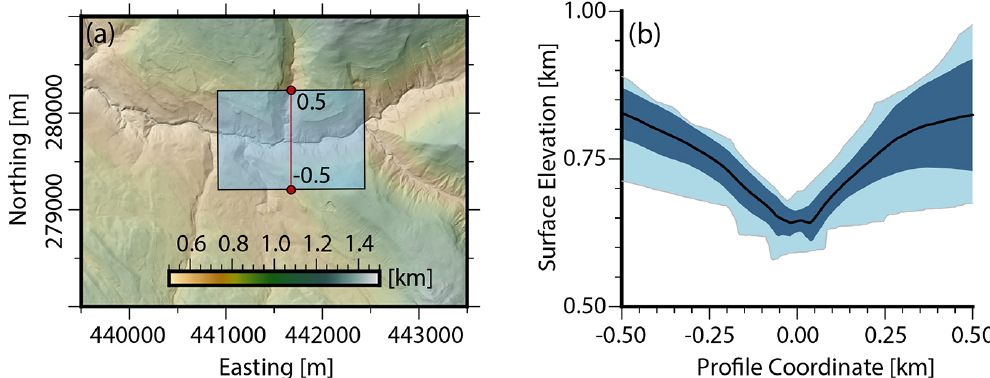
Figure 2. (a) Ordinary swath profile across the central part of the Taugl Gorge (Austria). The curves in (b) comprise the mean elevations (black line), extreme values (hull of the light blue area) and mean values ± 1 standard deviation (hull of the dark area). The data were derived from lidar based DEM data (spatial resolution 1m) in the MGI (Military Geographical Institute) Austria M31 coordinate system provided by the federal government of